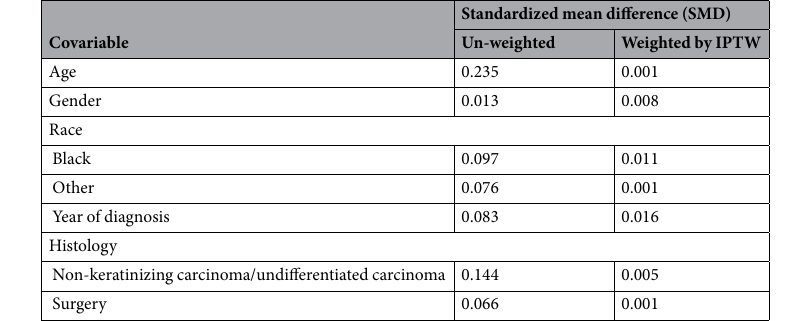
Table 4. Standardized mean difference of co-variables before and after weighting by